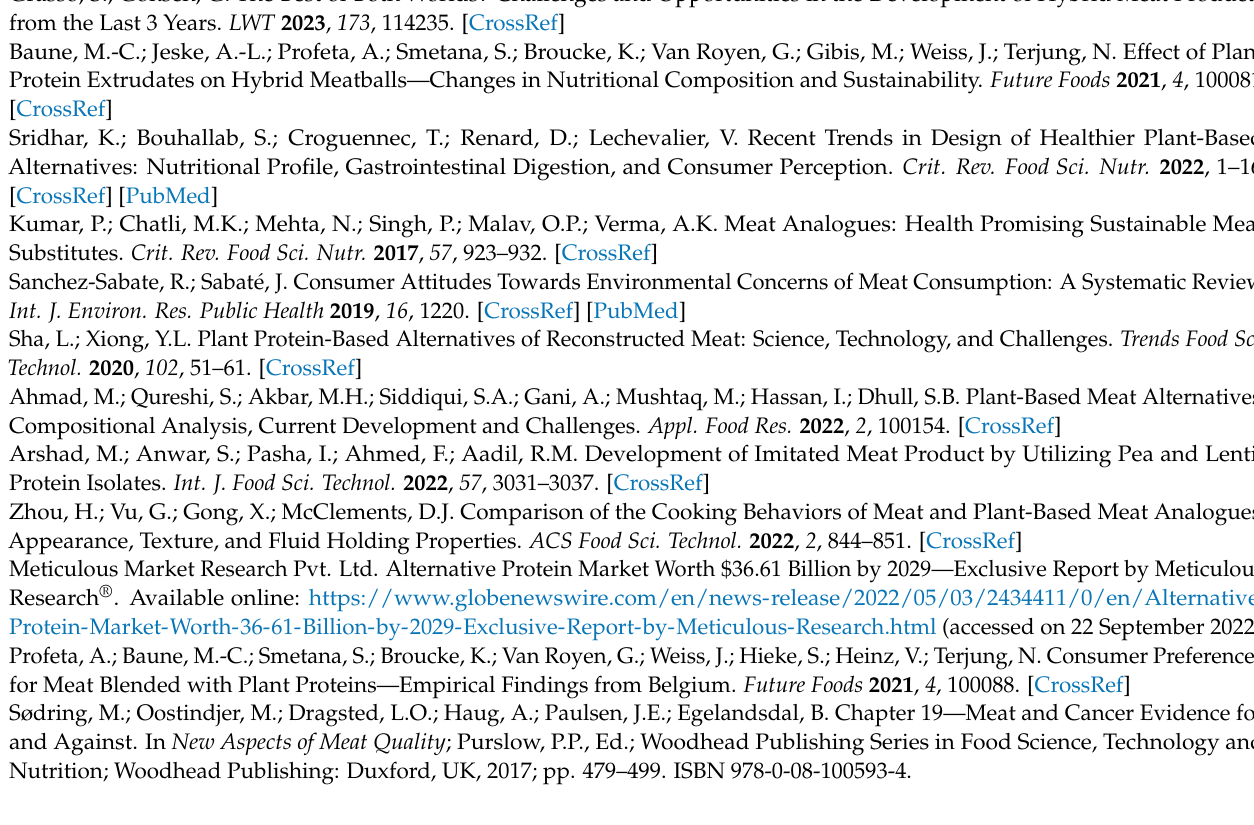
Figure A21. Effect of treatments and storage time on the b * coordinate of hybrid patty (HPPSV: HPP-SVCOOK).